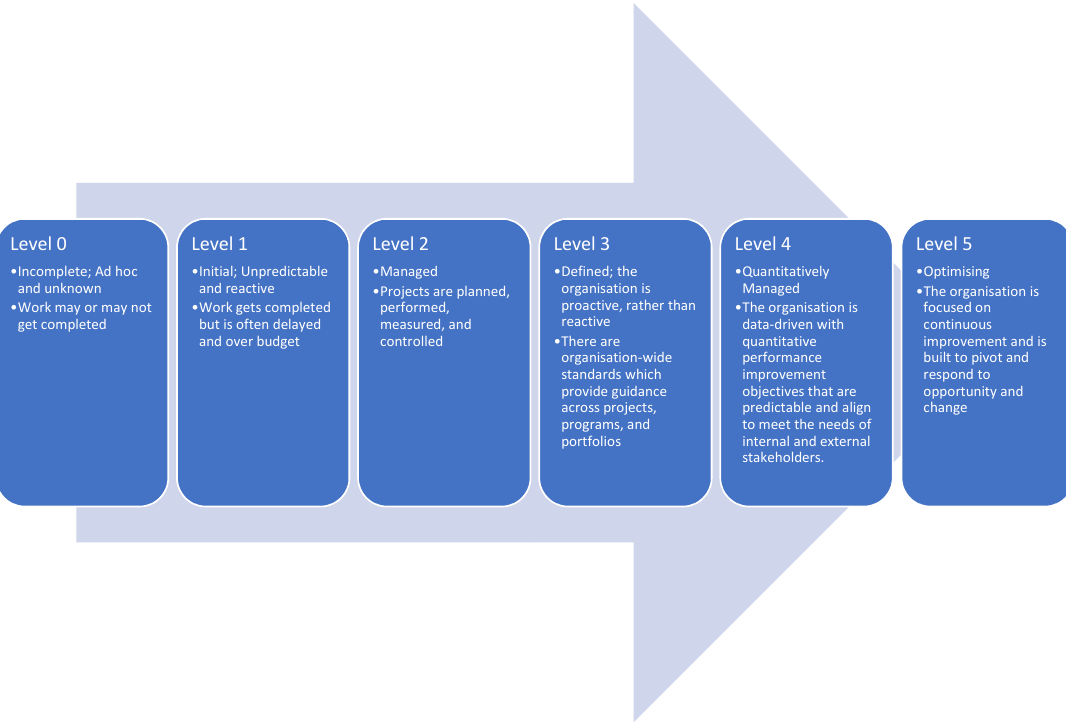
Figure 7. Maturity levels of the proposed